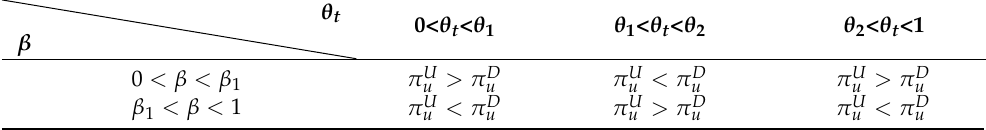
Table 6. The comparison of brick-and-mortar store’s profit between Scenario U and Scenario D. β